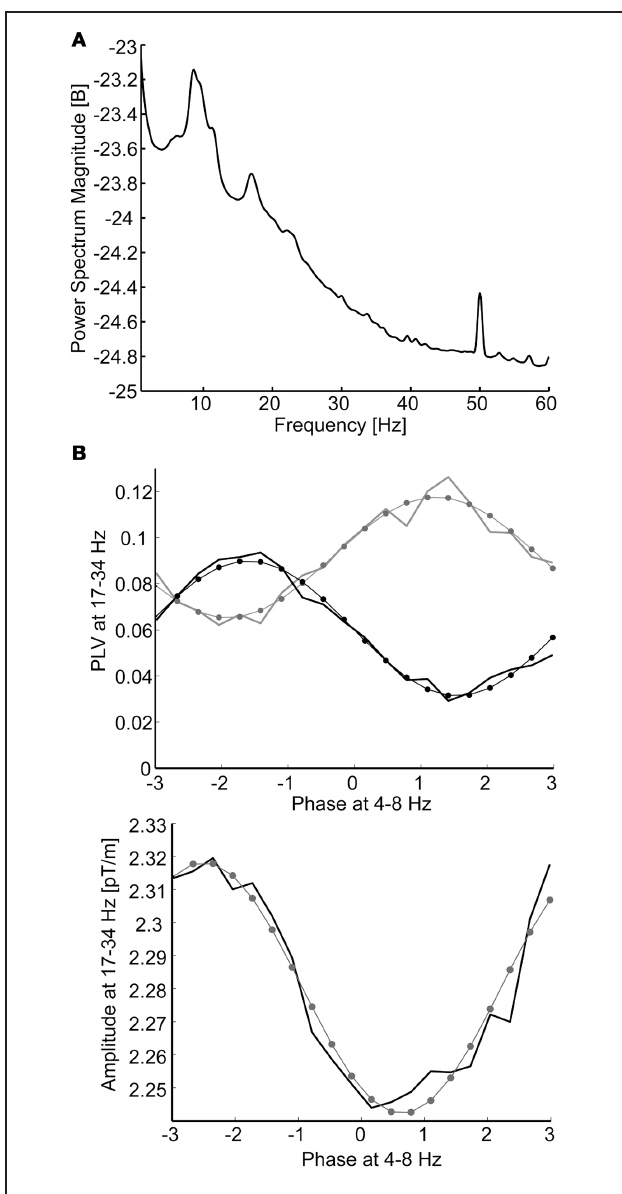
FIGURE 2 | (A) The grand average power spectrum pooled over all gradiometer channels and subjects. Only the 8–17Hz frequency band coincides with peaks in the spectrum. (B) Modulation of beta-band (17–34Hz) phase synchrony (above) and oscillation amplitude (below) as a function of theta-band (4–8Hz) phase. Data are sorted to 20 phase bins and modeled with sinusoidal fits to the data (thin lines with dots at bin centers). Data are from a single subject: nested synchrony of MEG channel 190 with channels 16 (black line) and 35 (gray line), illustrating antagonist synchrony modulation, and nested oscillation in channel 190. The adjusted R 2 goodness-of-fits were 0.97 and 0.95 (above) and 0.95